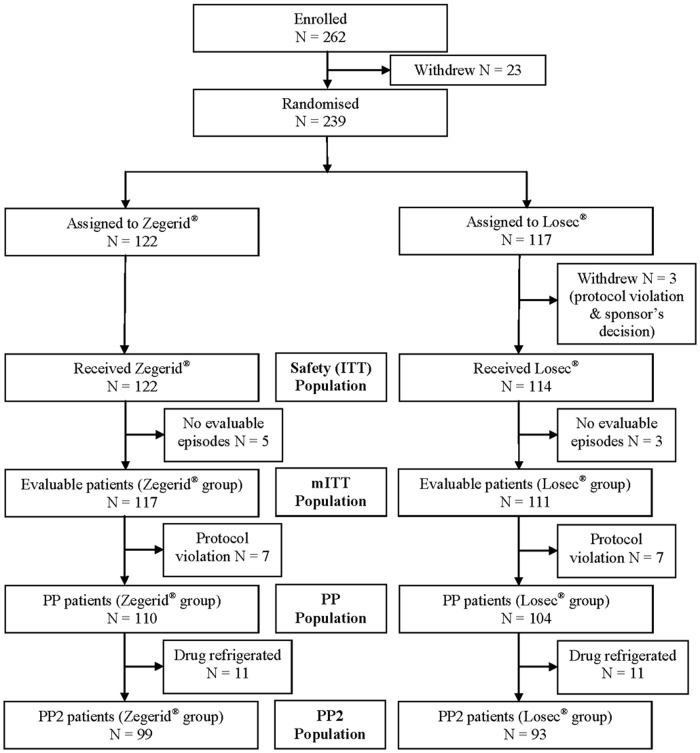
Study flow diagram.